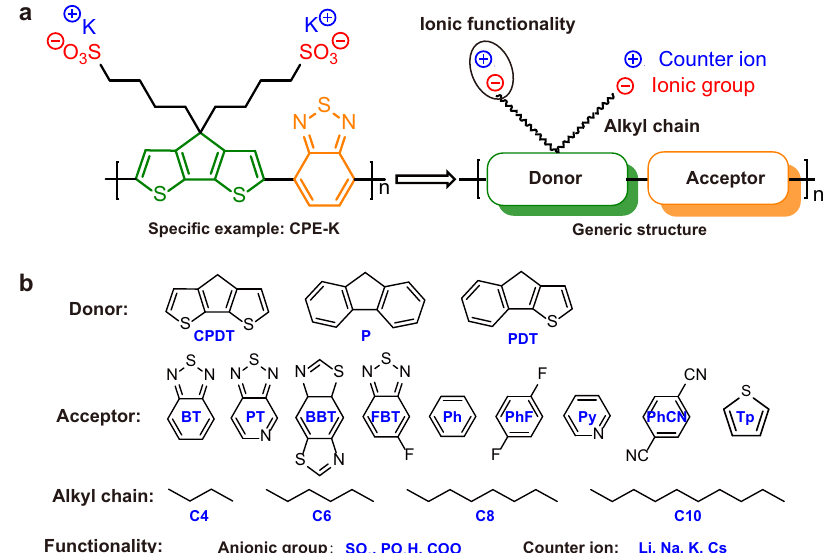
Fig. 1 Molecular structure of CPE-K. Illustration of the molecular structures and building blocks of anionic CPEs, including the donor and acceptor units on the backbone, alkyl chains, anionic groups, and counter ions.